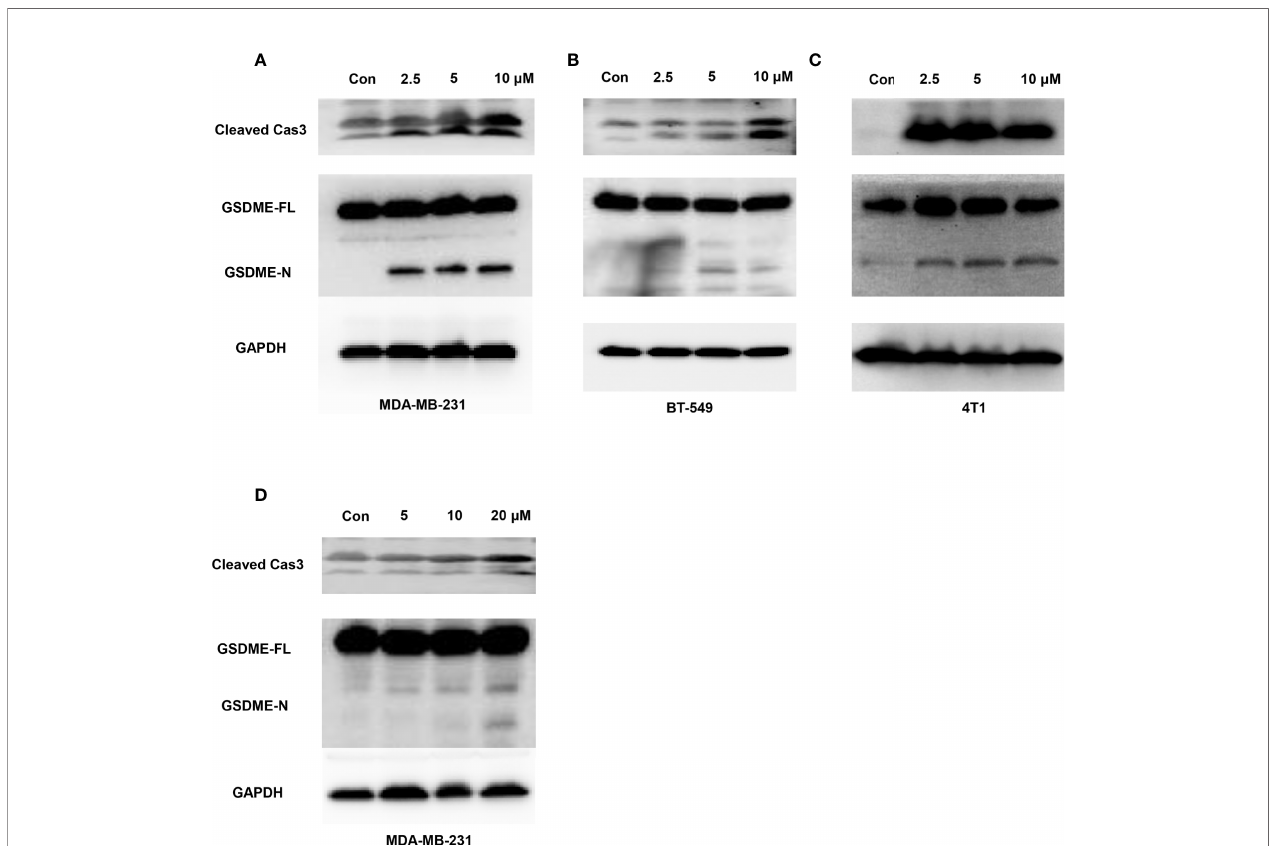
FIGURE 7 | Caspase-3-mediated cleavage of GSDME induced by Dinaciclib and Palbociclib in TNBC cells. Representative immunoblot analysis of cleaved caspase-3 and N-terminal fragments of GSDME in MDA-MB-231 (A) , BT549 (B) , and 4T1 (C) cells treated with Dinaciclib with 0, 2.5, 5, and 10 m M for 24 h. (D) Representative immunoblot analysis of cleaved caspase-3 and N-terminal fragments of GSDME in MDA-MB-231 cells treated with Palbociclib with 0, 5, 10, and 20 m M for 24 h. GAPDH was used as an internal